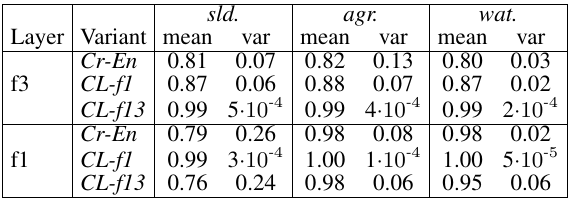
Table 6. Mean and variance of cosine similarities for three classes with ( CL-f1 , CL-f13 ) and without ( Cr-En ) cosine loss. Table 5. Results for land cover classification of variants of the Overall, this analysis indicates that some improvement for the cosine loss on dataset R 1 . OA: Overall Accuracy. Best scores underrepresented classes can be achieved if the cosine similar- are printed in bold font. ity loss is applied to the features just before the final